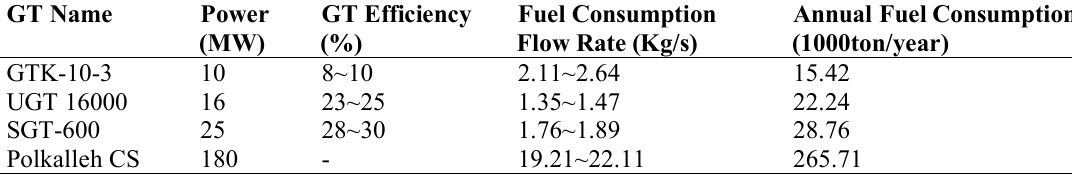
Table 6 . Natural gas consumption flow rate of each GT and the whole CS itself